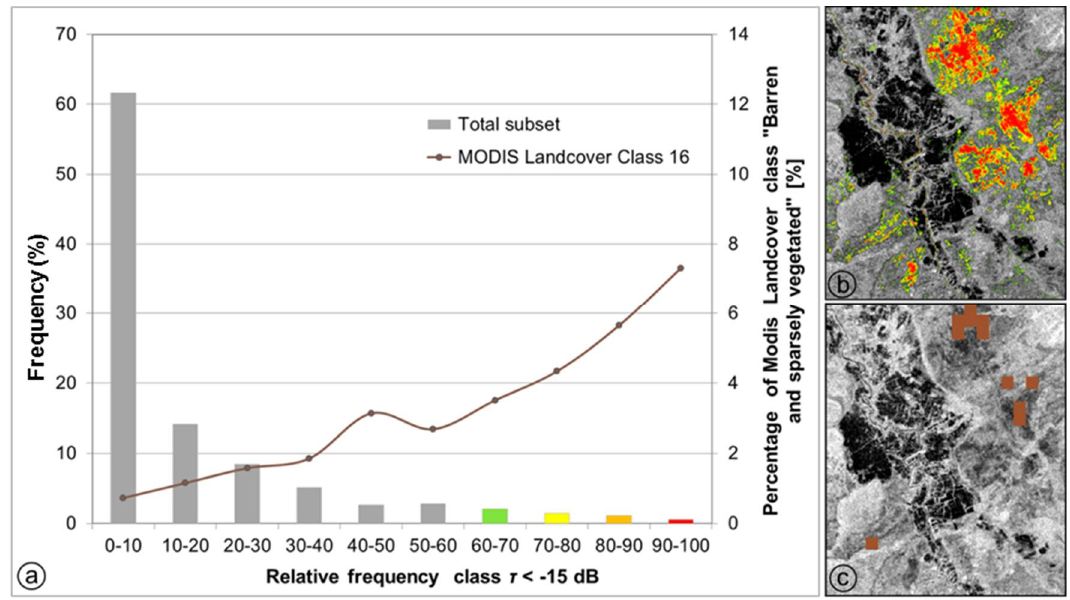
Figure 10. ( a ) Distribution of pixel frequencies of SEL 60–100% vs. MODIS Landcover (MCD12Q1) Class 16 (“Barren or sparsely vegetated”); ( b ) frequency classes 60–100% used for computing SEL 60–100% ; ( c ) MODIS Landcover Class 16.